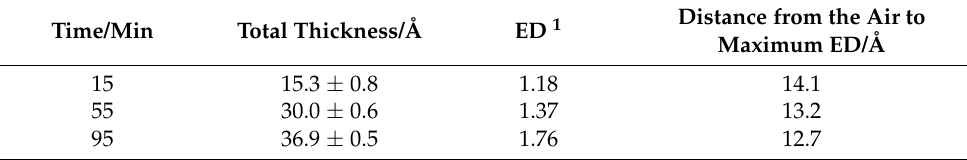
Table 2. Fitting results of the XRR measurements of PAA-G12 mixtures at c s = 0.1 mM and pH 11, as a function of time.